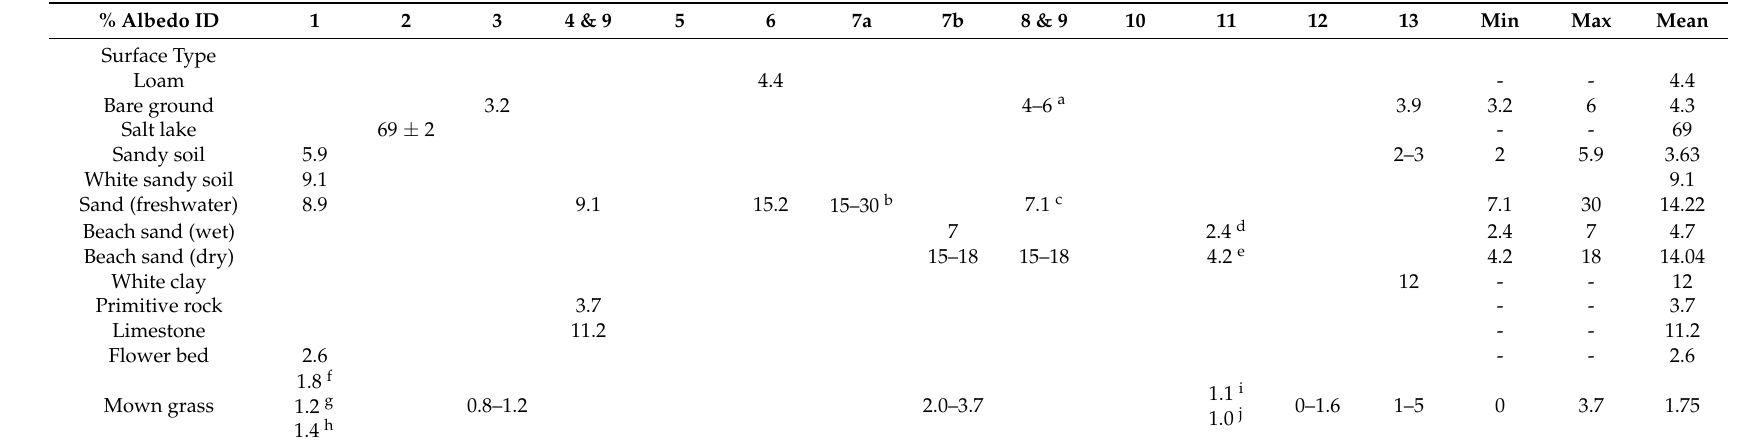
Table 3. Broadband UV albedo measurements of mostly natural surfaces in percentages as reported in the literature (Table 2). ID numbers in the top row correspond to the ID numbers assigned in Table